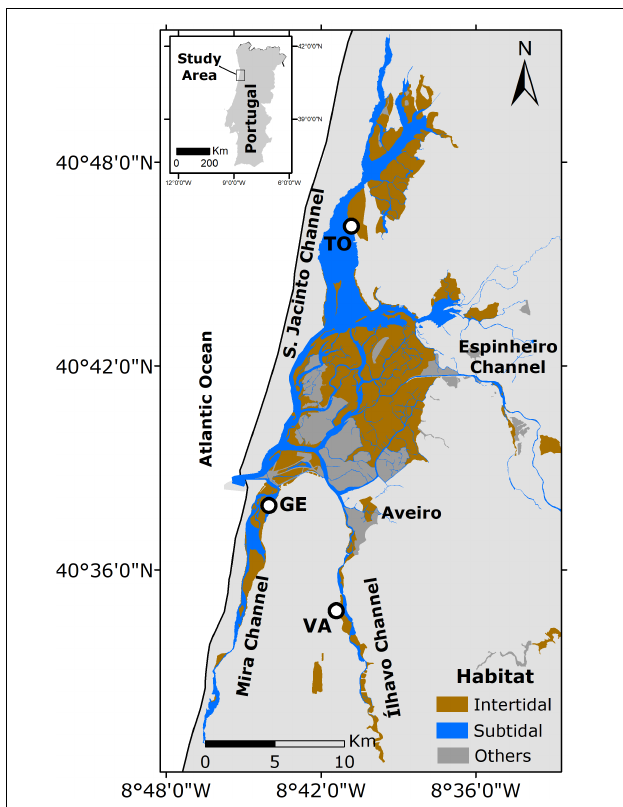
FIGURE 1 | Ria de Aveiro, Portugal. The different habitats are highlighted in green, for intertidal areas, blue for subtidal areas, and gray for other areas (e.g., salt pans). Sampling sites are marked with a black dot: Vista Alegre (VA), Gafanha da Encarnação (GE), and Torreira